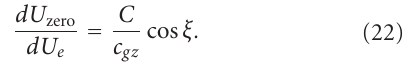
Using (7) and (8), changes in U zero over time can be